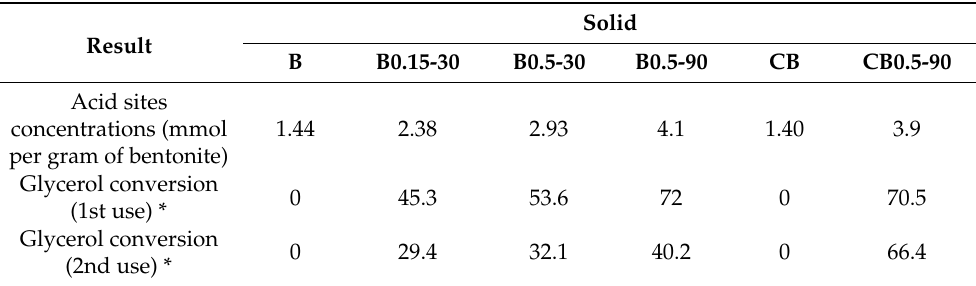
Table 5. Determination of the number of acid sites present in solids and catalytic activity in the solketal synthesis reaction. * Reaction conditions: T = 50 ◦ C; t = 30 min; A/G = 6; bentonite to glycerol mass ratio =